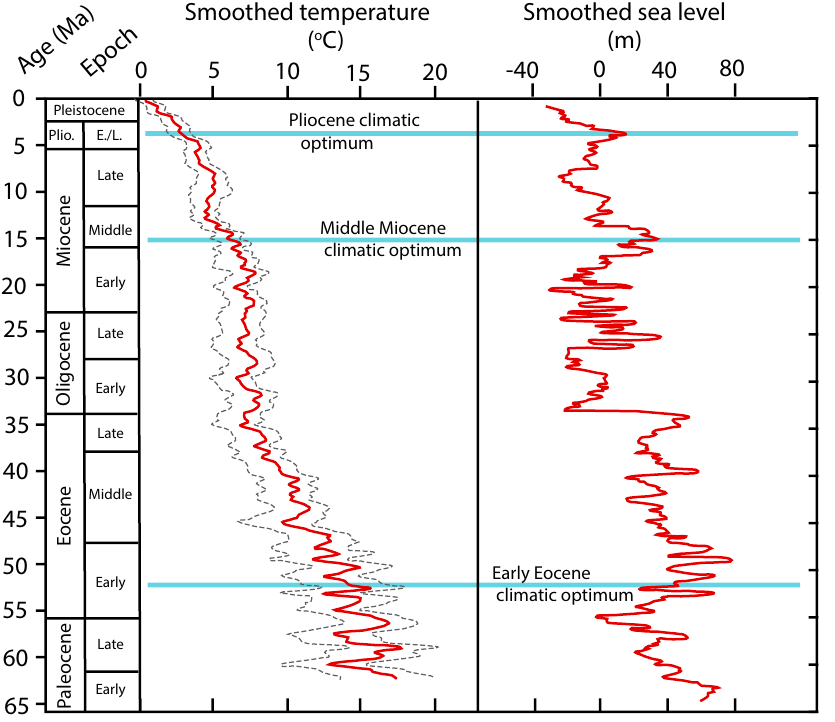
Figure 1. Geological history of sea-surface temperature and sea-level changes for the Pacific Ocean basin through the last 65 million years (modified from Miller et al., 2020)